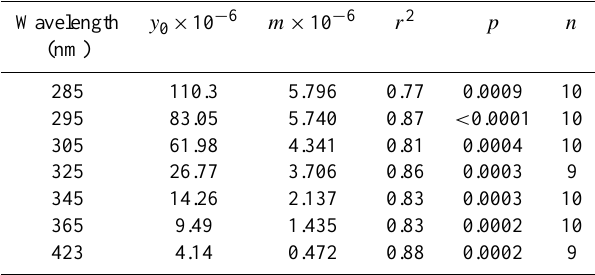
Fig. 4. Measured riverine: estuarine and coastal seawater carbon monoxide apparent quantum yields (CO AQYs) versus sample ab- sorption coefficient at 412nm (CDOM a 412 ). Black fill squares are from the North Tyne: River Tyne: Tyne estuary and coastal North Sea (North East England); grey fill diamond is from the South Tyne (North East England); grey fill square is from the Tamar River (South West England); and no fill diamond is from the River Tay (South East Scotland). Straight lines are linear regressions of all data: where CO AQY λ = y 0 + m × a 412 : y 0 is the y -intercept (CO AQY) and m the slope of linear regressions of CO AQY at wave- length: λ : against sample CDOM absorption coefficient at 412nm ( a 412 ). Statistics for the curves are as follows: